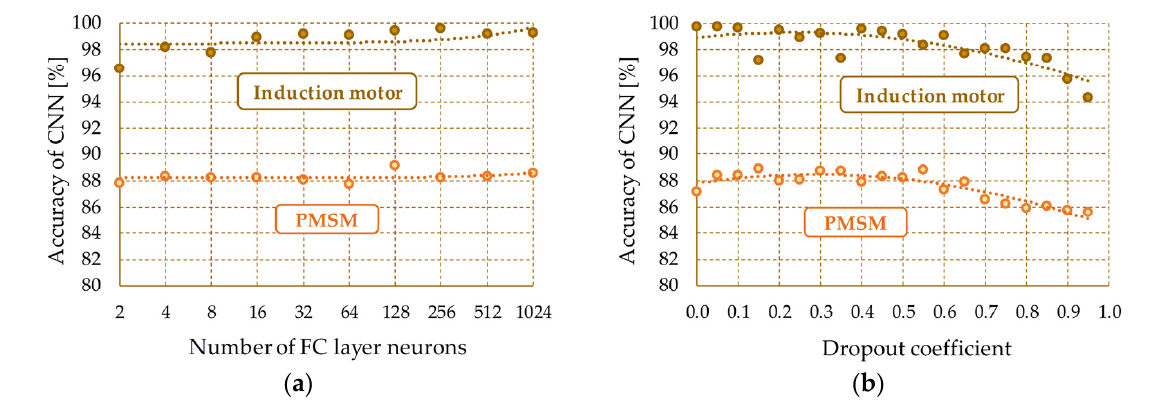
Figure 9 . Analysis of the effectiveness of the CNN network—learning curves: ( a ) the effect of the number of neurons in the FC layer; ( b ) the effect of the dropout factor.